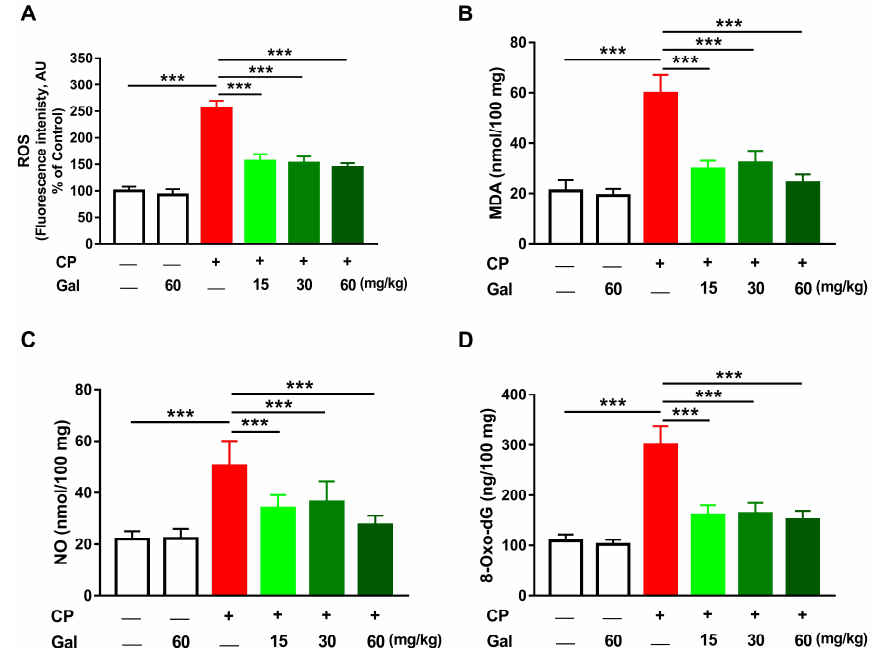
Figure 4. Galangin (Gal) suppresses oxidative stress in CP-intoxicated rats. Gal suppressed hepatic ( A ) reactive oxygen species (ROS), ( B ) malondialdehyde (MDA), ( C ) nitric oxide (NO), and ( D ) 8-Oxo-dG. Data are mean ± SEM, ( N = 6). *** P < 0.001.